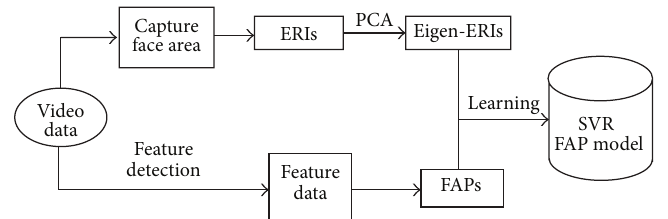
Figure 5: Offline learning